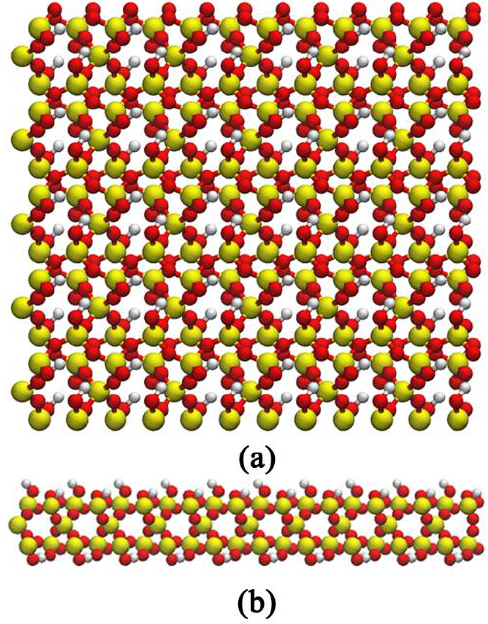
Figure 1. ( a ) Top view and ( b ) side view of hydroxylated-quartz.